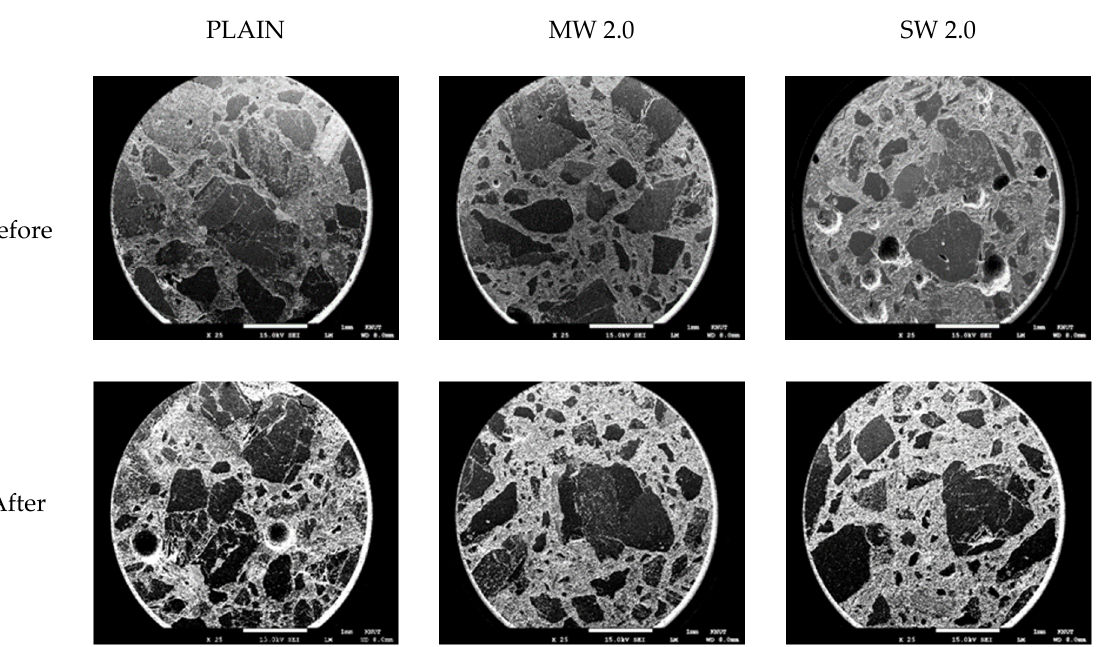
Figure 9. Scanning electron microscopy (SEM) images before and after damage by sulfuric acid attack.